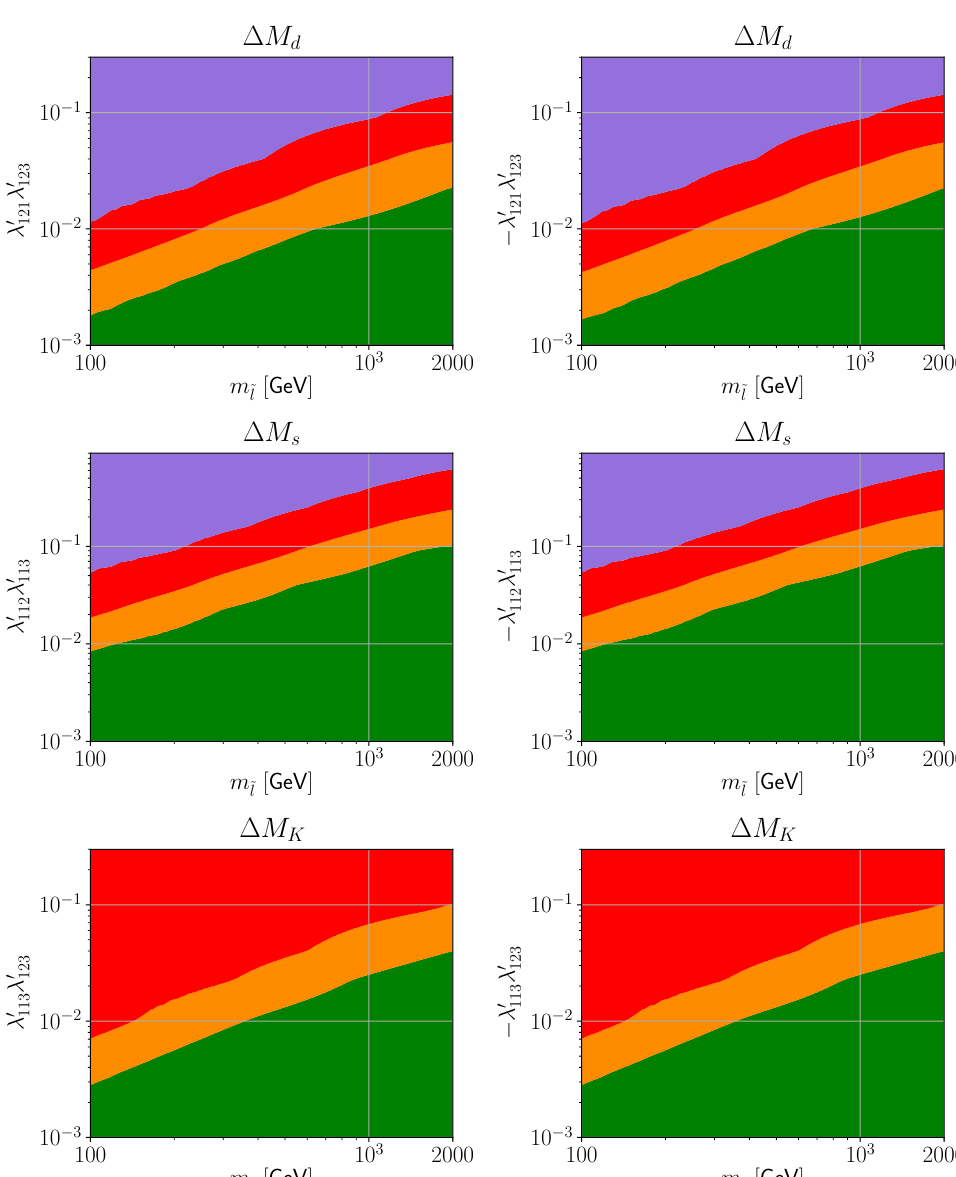
Figure 4. Constraints from the (cid:1) M ’s on scenarios with RpV-mediated (cid:13)avor violation of LQ (cid:22) D - type, where the RpV-violating contribution is dominated by a box diagram. The limits are plotted against the slepton mass and follow the same color-code as (cid:12)gure 3. For these plots, the parameter set of the scenario SUSY-RpV(a) of table 1 has been employed.